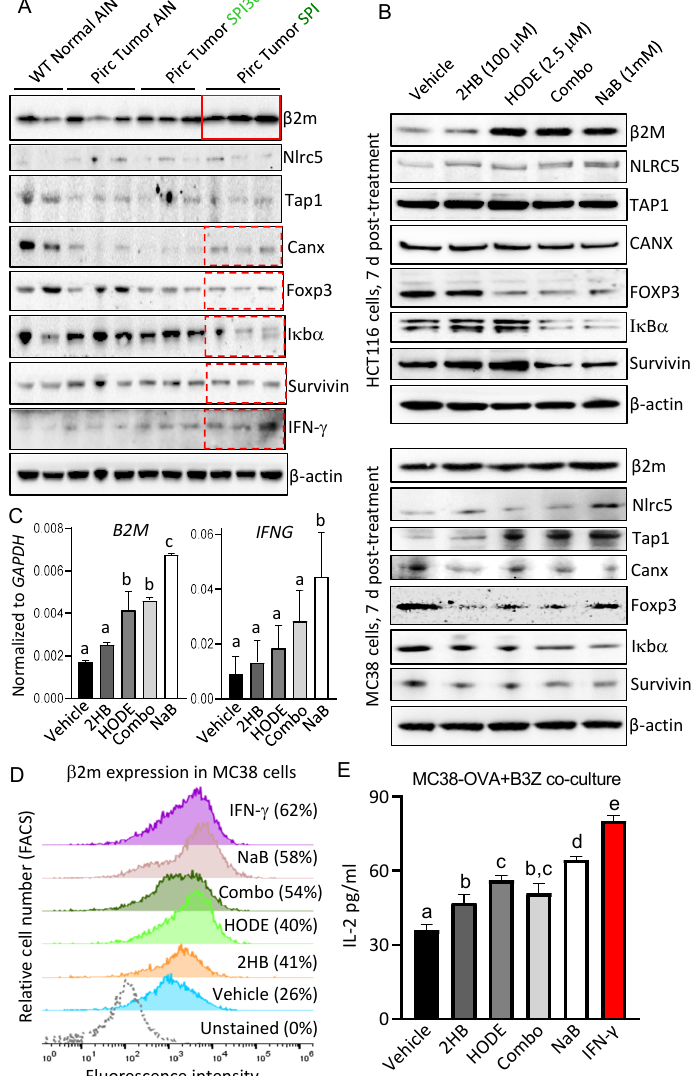
Figure 8. 13(S)-HODE and (S)-2HB target the IFN- γ signaling axis. ( A ) Immunoblotting of Pirc and WT tissues. Each lane represents an individual tumor or normal tissue. ( B ) Immunoblotting of HCT116 and MC38 cells 7 d after treatment with 100 µ M (S)-2HB, 2.5 µ M 13(S)-HODE, or 100 µ M (S)-2HB plus 2.5 µ M 13(S)-HODE, with 1 mM NaB as a control. ( C ) B2M and IFNG mRNA expression in HCT116 cells following 7-d treatments as in ‘B’, RT-qPCR data normalized to GAPDH ; mean ± SD, n = 3. ( D ) FACS-based analysis of β 2m cell suface occupancy in MC38 cells 7 d after treatment with test agents as in ‘B’, or with IFN- γ (10 ng/mL) for 20 h. ( E ) Immunoassay-based assessment [17] of ovalbumin (OVA) antagonistic peptide-driven IL-2 secretion from murine OVA-specific B3Z T cell hybridoma co-incubated with MC38-OVA cells [16], treated as in panel ‘C’. Mean ± SD, n = 3. Bars with different superscripts differed significantly based on group comparisons via one-way